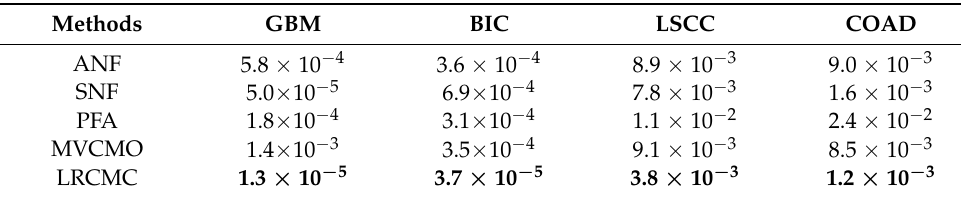
Table 4. p values of survival analysis in Cox log-rank model for different clustering methods of four cancers on The Cancer Genome Atlas (TCGA) datasets.